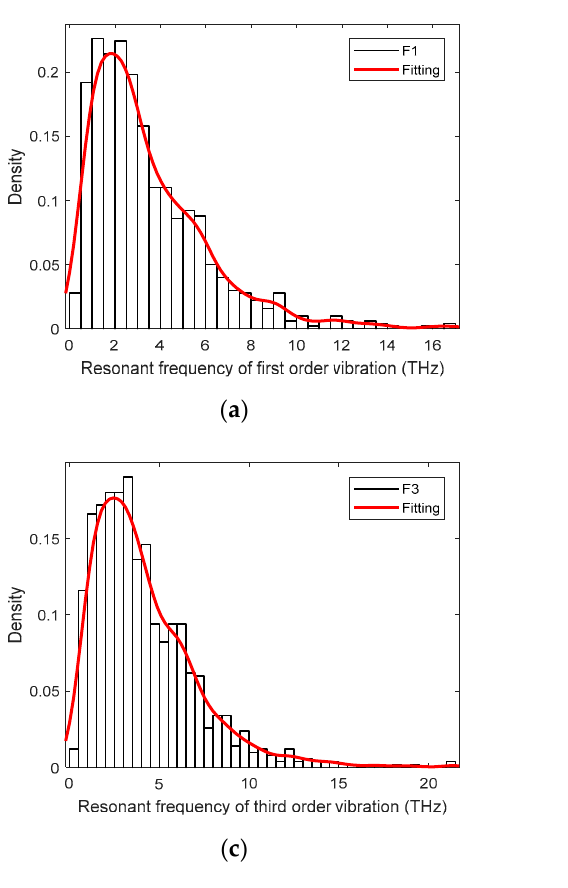
Figure 7. The probability density distribution of resonant frequency in the finite plane element model of graphene. ( a – d ) are for the first-fourth resonant vibration, respectively.